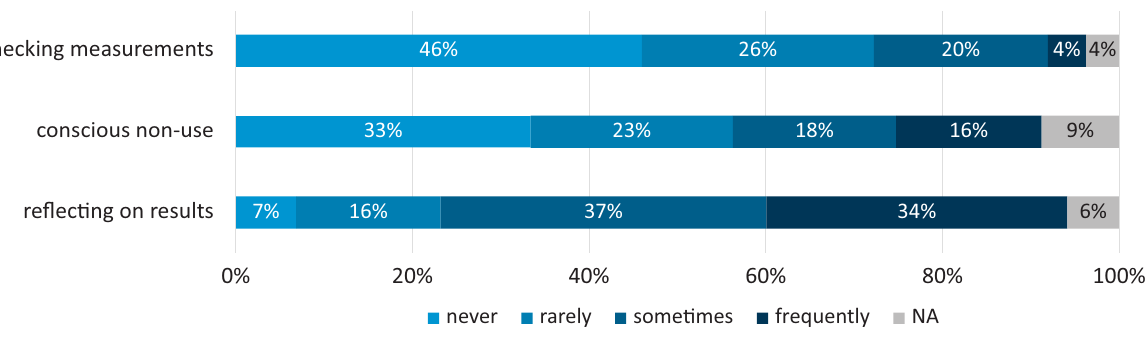
Figure 3. Distribution of indicators of coping